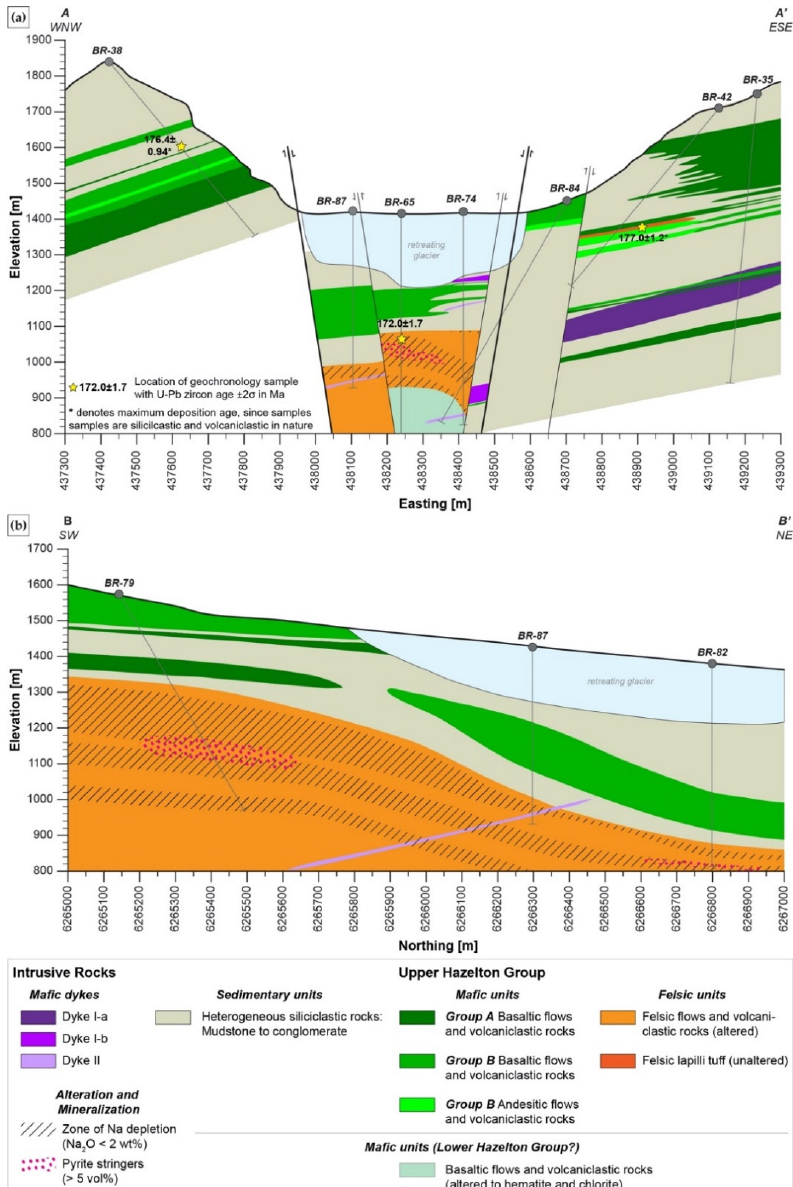
Figure 4. Stratigraphic cross-sections at the A6 Anomaly, locations are shown in Figure 3b. ( a ) A-A’ is running perpendicular to NNW-NW dipping strata and is based on drill holes BR-35, -38, -42, -65, -74, and -87; there is a series of normal faults that form a horst and graben structure, of which age data are from [45]. ( b ) B-B’ is a stratigraphic long section parallel to the retreating glacier based on stratigraphy in drill holes BR-79, -82, and -87. (modified after Brueckner [23]).